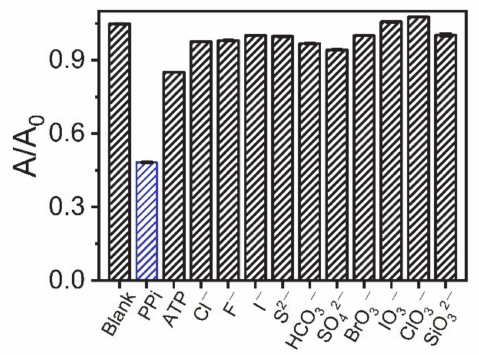
Figure 4. Determination of various interfering ions (20 µ M additions).